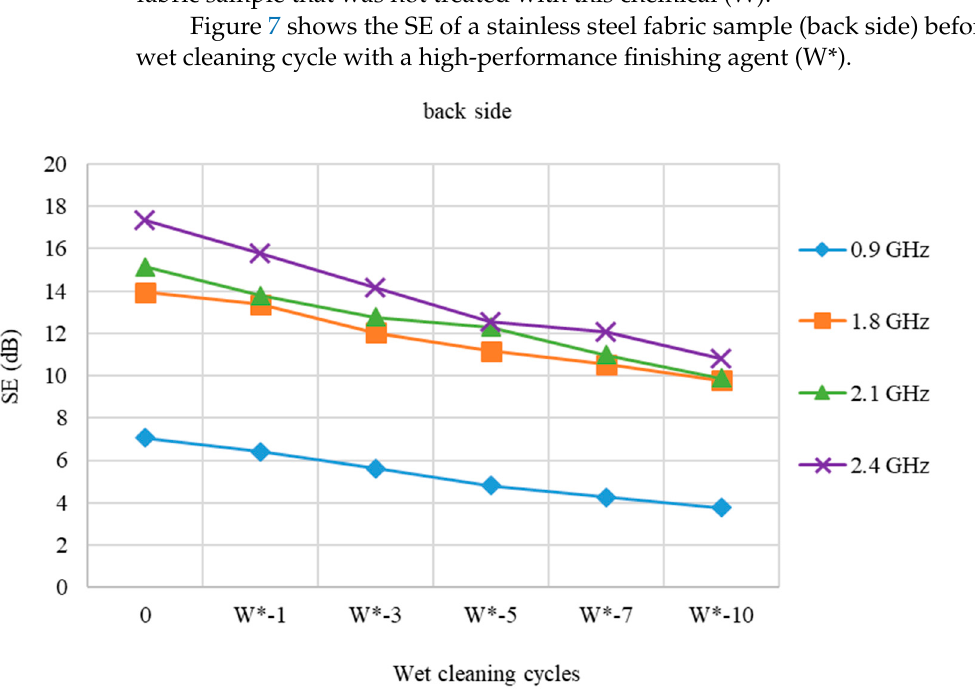
Table 5. Shield effectiveness of PES/CO/SS fabric (face side) before and after 10 cycles of professional care (P-10, W-10, W*-10) at the frequencies 0.9 GHz, 1.8 GHz, 2.1 GHz, and 2.4 GHz. f (GHz) 0.9 Fabric Fabric SE (dB) Pristine